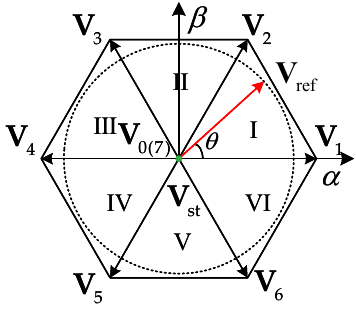
Figure 3. Switching vectors generated by the qZSI in the vector